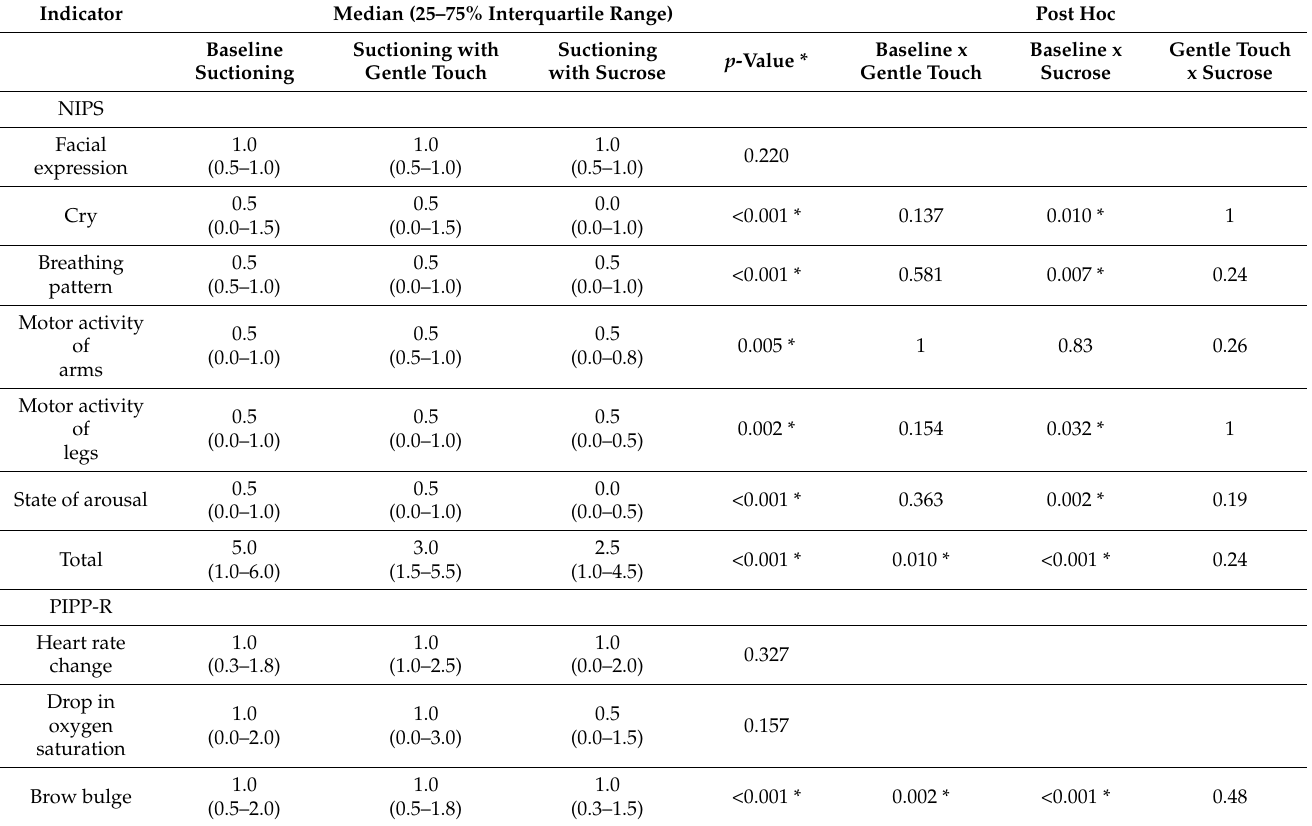
Table 2. Median scores, standard deviation, confidence intervals, and comparison of NIPS and PIPP-R between the three conditions.